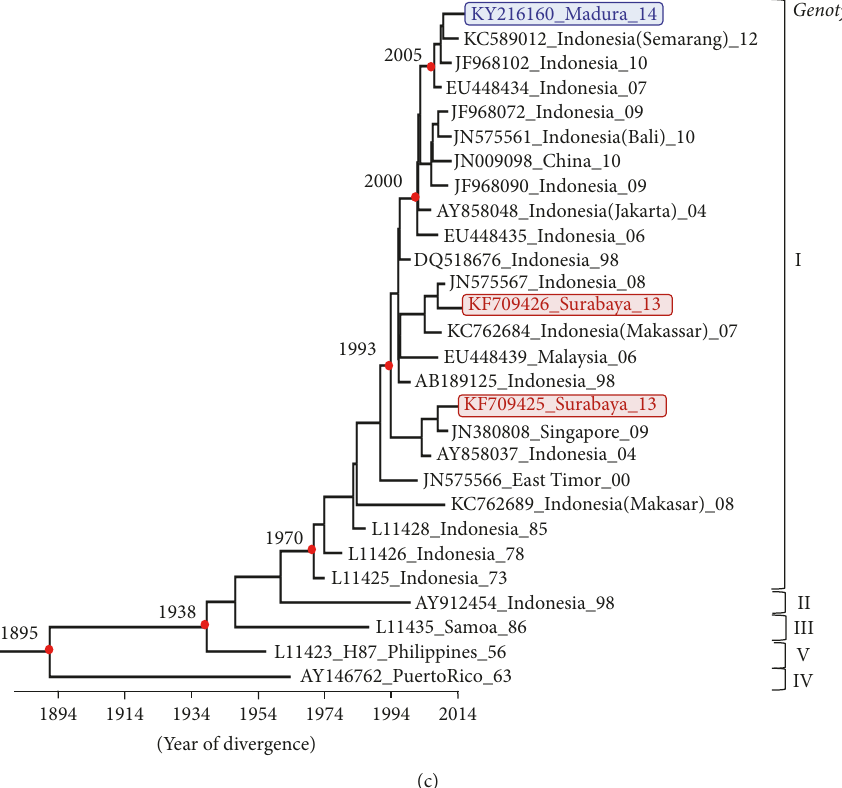
Figure 2: Phylogenetic trees of DENVs isolated in Bangkalan, Indonesia. Phylogenetic trees of DENV-1 (a), DENV-2 (b), and DENV-3 (c) were constructed using Bayesian Markov chain Monte Carlo (MCMC). The GenBank accession number, country/city, and year of isolation were shown in that order. The Bangkalan and Surabaya isolates were shown in blue and red, respectively. Filled red circles indicate statistical support at some key nodes. Posterior probability value > 0.9. Horizontal branches are drawn to the scale of the estimated year of